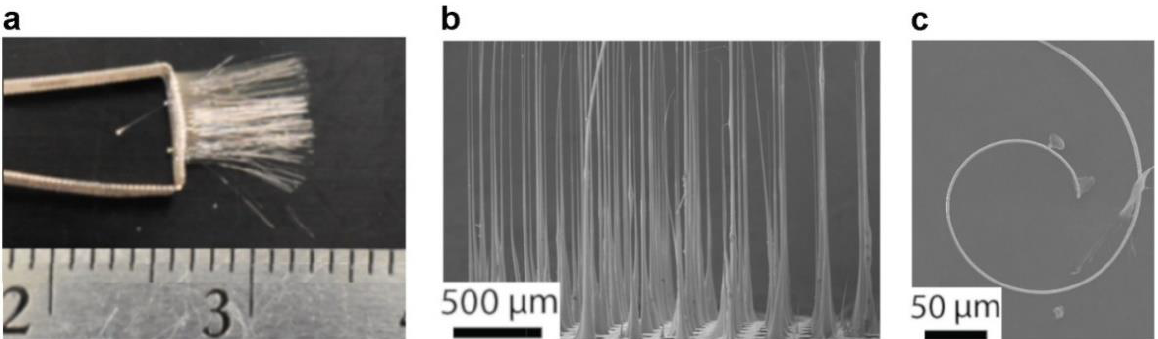
Figure 5. High-aspect ratio Pt-BMG microfibers drawn at 265 °C and pulling velocity of 20 mm/min. ( a , b ) Arrays of microfibers drawn from a 200 µm steel mesh. ( c ) A very high-aspect ratio uniform microwire drawn from single cavity machined in aluminum.